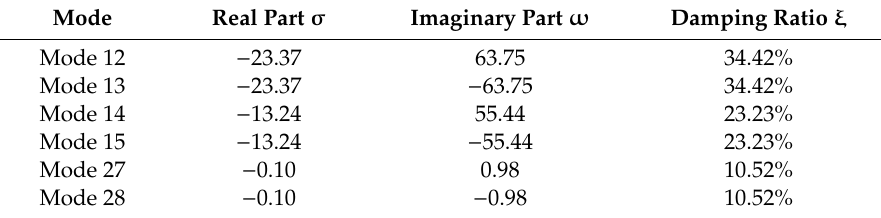
Figure 7. Eigenvalue plot, operating point 1, SVC disconnected. Table 4. Oscillatory modes, operating point 1, SVC disconnected.